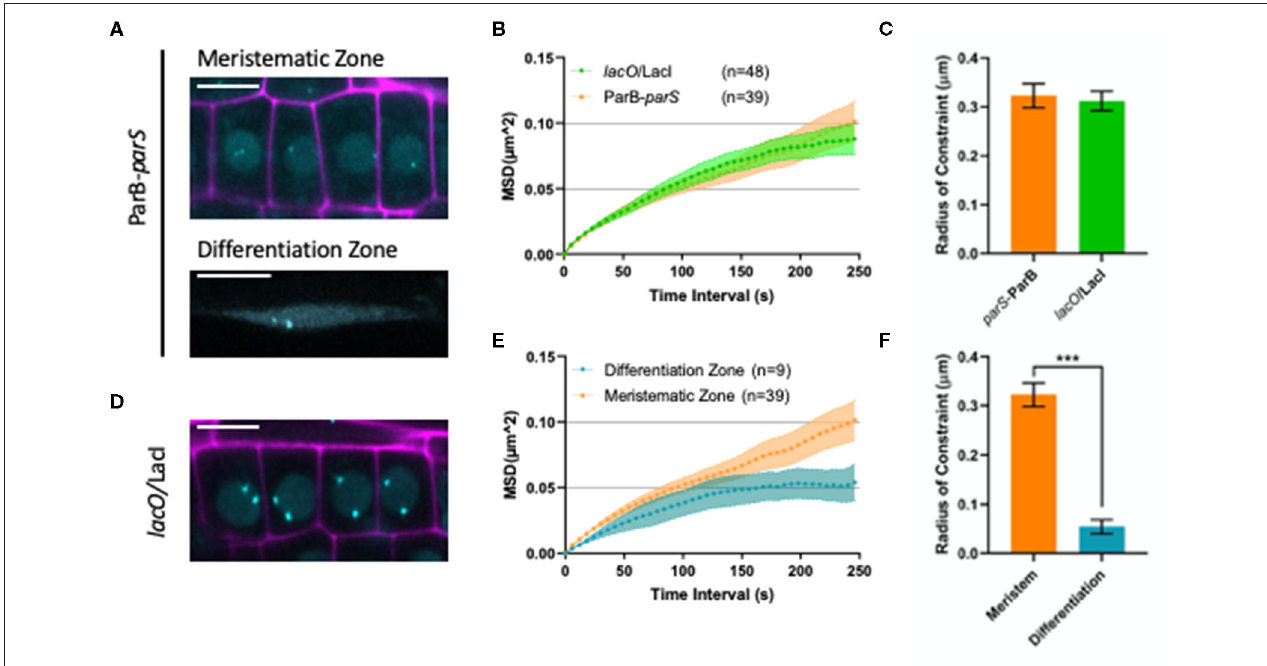
FIGURE 5 | Analyzing chromatin mobility using the ANCHOR system. (A) Representative images of ParB- parS line in meristematic (upper panel) and differentiation zone (bottom panel)showing nuclear signal with spots (cyan). Propidium iodide (PI) staining is shown in magenta. Bars = 10 µ m. (B) The MSD analysis for lacO /LacI and ParB- parS lines based on time lapse experiment of nuclei in the meristematic zone. The values represent means ± SEM from 48 and 39 cells, respectively. (C) Calculated radius of constraint for MSD curves depicted in (B) . The values represent means ± SEM. Student’s t- test, *** P < 0.001. (D) Representative image of lacO /LacI line in meristematic region showing nuclear signal with spots (cyan). PI staining is shown in magenta. Scale bar = 10 µ m. (E) The MSD analysis for ParB- parS lines based on time-lapse experiments of nuclei in the meristematic and differentiated zone. 3D stacks were taken at 6 s intervals for 5min. The values represent mean ± SEM from 39 and 9 cells, respectively. (F) Calculated radius of constraint for MSD curves depicted in (E) . The values represent means ±